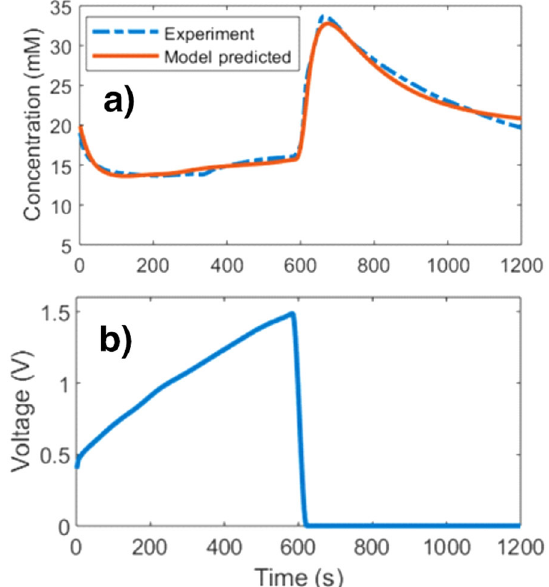
Fig. 4 The performance over time of an MCDI cell in CC mode. For this MCDI device, the data was retrieved from ref. 48 and the model fi tting was based on Eq. 11. a The cell ef fl uent concentration over time. b The applied voltage during the CC operation which was used as an input for the fi tting in a .